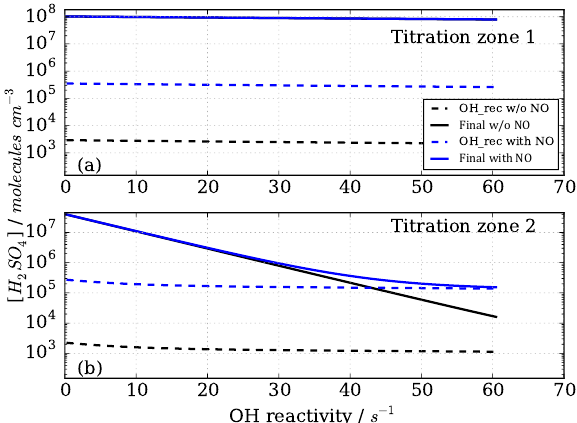
Figure 6. Modelled CIMS H 2 SO 4 concentrations for CO as OH re- actant in titration zone 1 (a) and titration zone 2 (b) with and without NO impurity (140ppt) present. Final concentrations describe dif- ferential between total signal and total background mode measure- ments. OH_rec describe the H 2 SO 4 concentrations derived from re- cycled OH only, contributing to the total